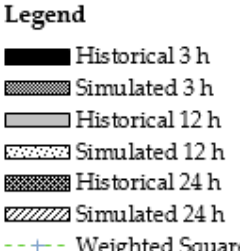
Figure 4. Comparison of: ( a ) mean; ( b ) variance; ( c ) lag 1 autocovariance; and ( d ) proportion of dry